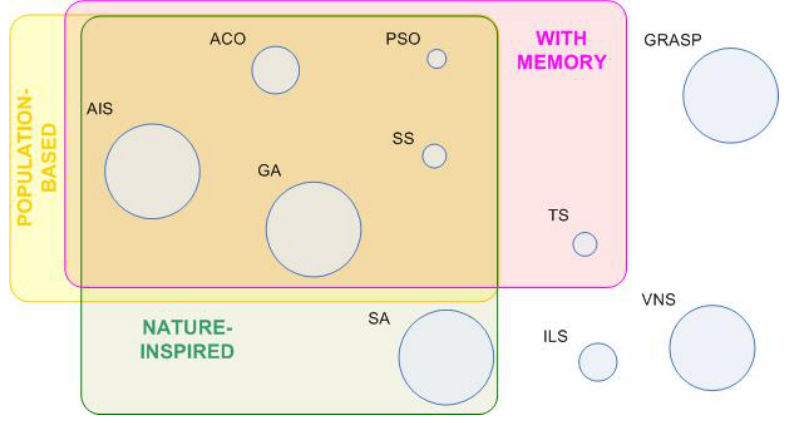
Fig. 2. Main metaheuristics grouped by different criteria. Circles’ size is proportional to the number of Google Scholar indexed articles, from 2006 to 2015, that include the complete name of the specific metaheuristic and “metaheuristics” or “heuristics” in the article (March 15, 2016).